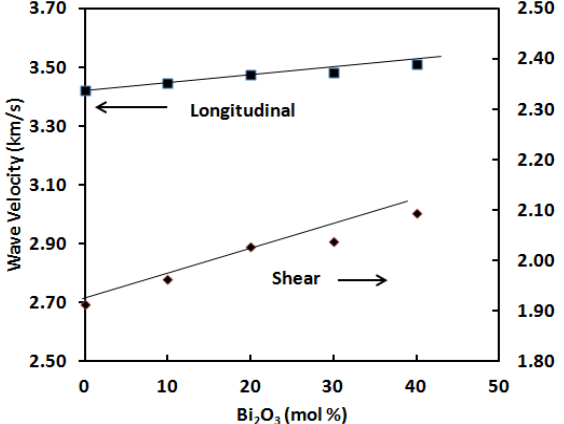
Figure 3. Longitudinal and shear ultrasonic velocities at room temperature in ternary